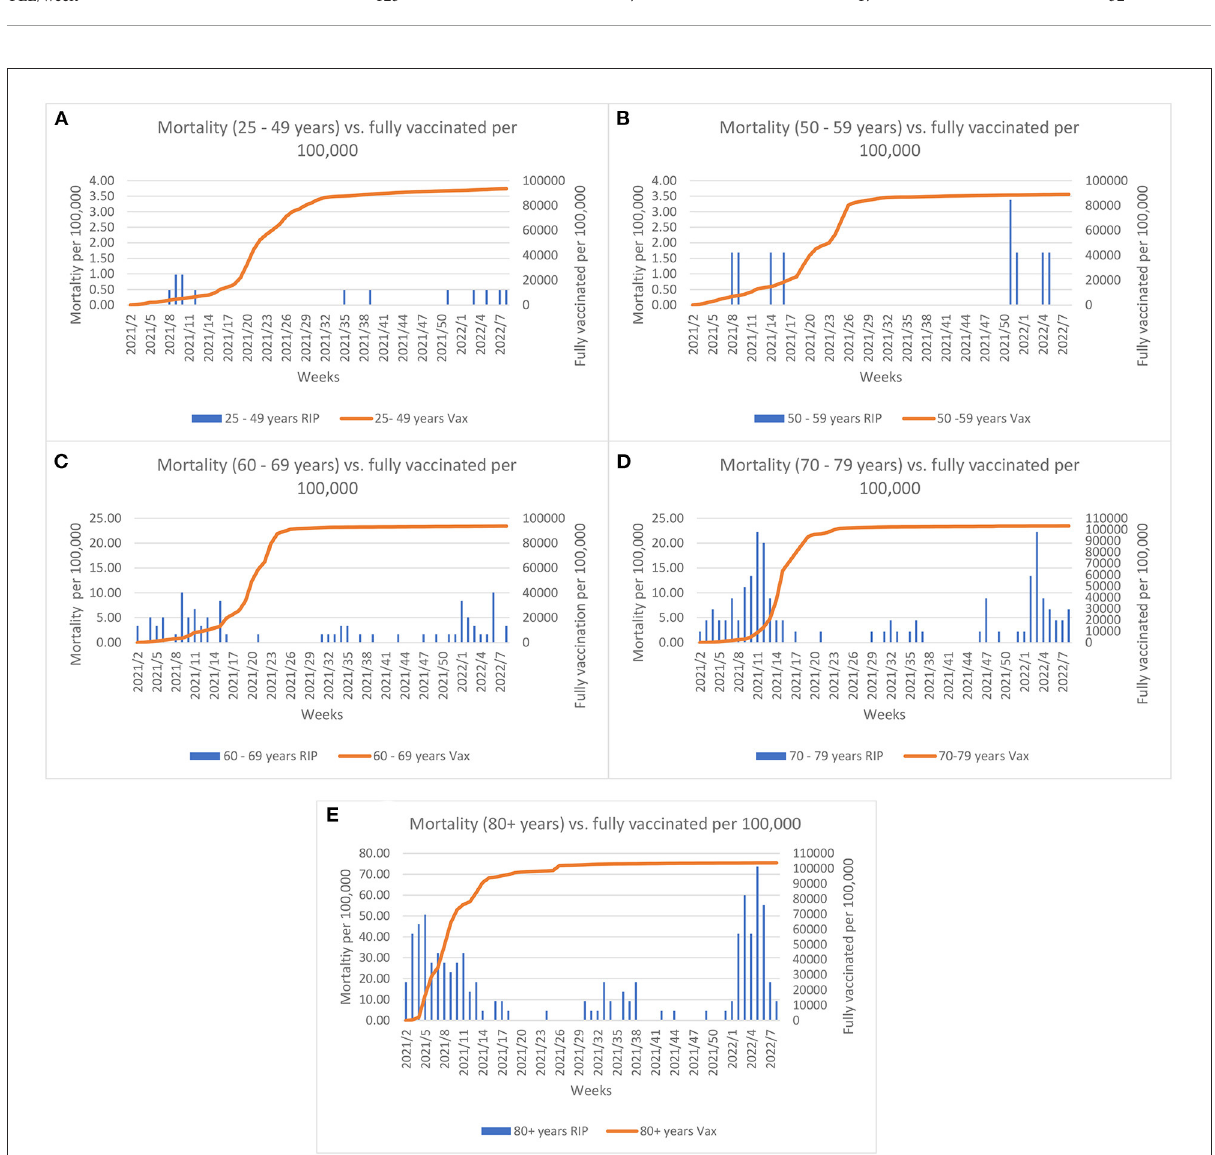
FIGURE2 Comparisons between morality rate and full vaccination (2 doses or 1 Janssen dose) coverage per 100,000 across age groups and weeks since initiation of vaccine rollout. Left y-axis Graph (A,B) scale represents mortality up till 4 per 100,000; Graph (C,D) scale represents mortality up till 25 per 100,000 and Graph (E) represents mortality up till 80 per